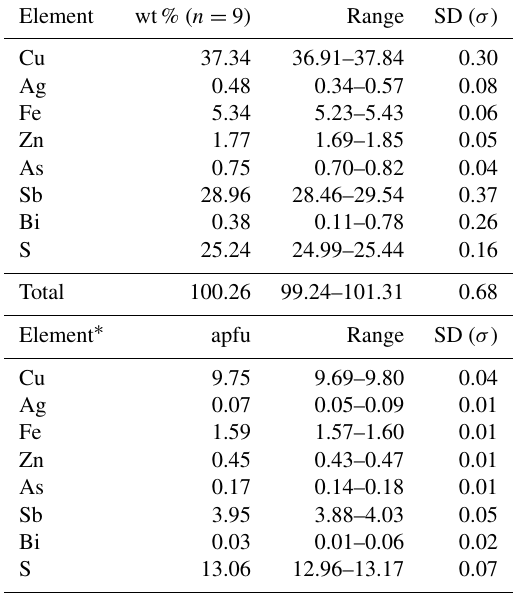
Table 2. Electron microprobe analyses of tetrahedrite-(Fe).